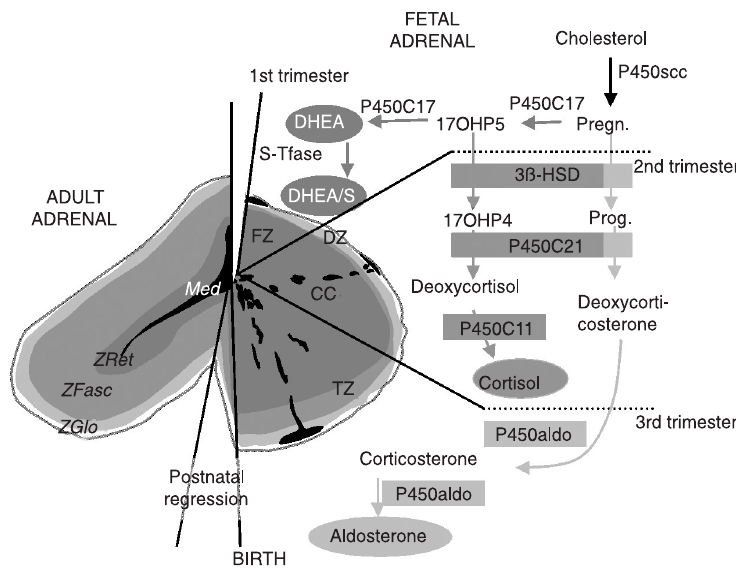
Figure 1. Ontogenesis of steroidogenic enzymes in the human fetal adrenal gland. This schematic representation is divided into portions showing the fetal adrenal gland (right) at the first, second and third trimesters of pregnancy, and the adult adrenal gland (left). During the first trimester, the fetal gland is composed of a definitive zone (DZ, light grey) and a fetal zone (FZ, dark grey). The fetal zone, expressing the P450C17 cytochrome, is responsible for massive secretion of DHEA and DHEA/S, used by the placenta as estrogen precursors. During the 2nd trimester, chromaffin cells (CC, black) originating from the neural crests migrate through the fetal cortex to progressively colonize the center of the gland to form the future medulla ( Med ). At the end of the 2nd trimester, the newly constituted transitional zone (TZ, medium grey) acquires the enzyme 3ß-HSD while the expression of P450C17 remains, thus allowing the production of fetal cortisol. Near birth, cells of the definitive zone which express only 3ß-HSD, acquire the P450aldo and begin to secrete mineralocorticoids such as aldosterone. Shortly after birth, the fetal adrenal regresses strongly (mainly due to the regression of the fetal zone) and recovers progressively during the first years of extra- uterine life. Finally, the adult adrenal gland is composed of the zona glomerulosa ( ZGlo , light grey), zona fasciculata ( ZFasc , medium grey) and zona reticularis ( ZRet , dark grey) responsible for the production of mineralocorticoids (aldosterone), glucocorticoids (corti- sol) and androgens (DHEA-DHEA/S), respectively. P450scc = cytochrome P450 side chain cleavage; Pregn. = pregnenolone; P450C17 = cytochrome P450 17 α -hydroxylase, 17-20 lyase; 17OHP5 = 17-hydroxy-pregnenolone; DHEA/S = dehydroepiandrosterone- sulfate; S-Tfase = DHEA sulfotransferase; 3ß-HSD = 3ß-hydroxysteroid dehydrogenase; Prog. = progesterone; 17OHP4 = 17-hydroxyprogesterone; P450C21 = cytochrome P450 21-hydroxylase; P450C11 = cytochrome P450 11ß-hydroxylase; P450aldo = cytochrome P450 aldosterone synthase. Adapted from Ref.